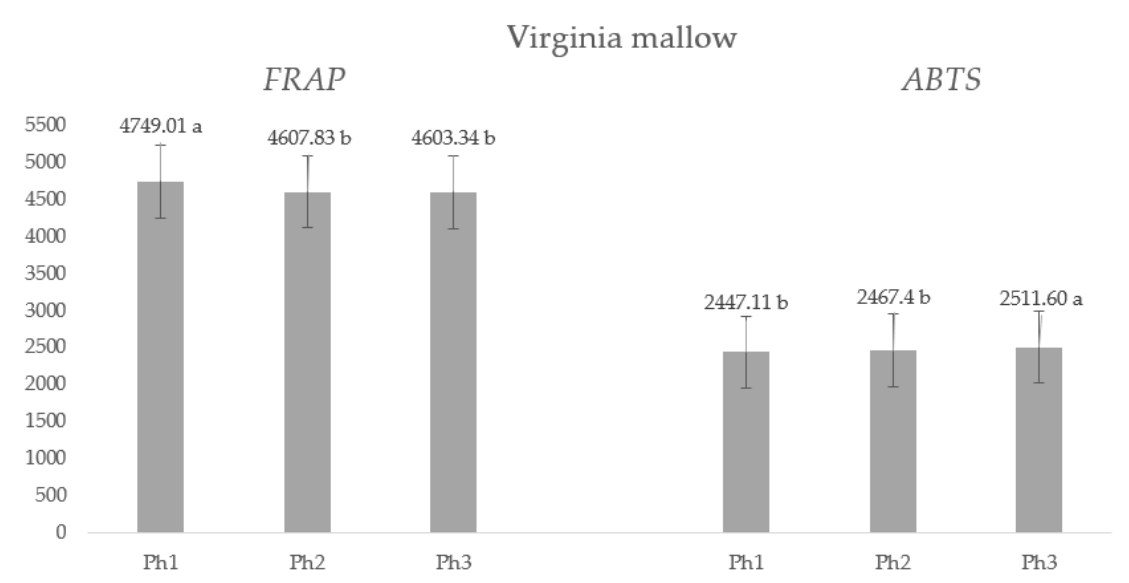
Table 5. Pigment compounds content of Virginia mallow and cup plant leaves in different phe- nophases.